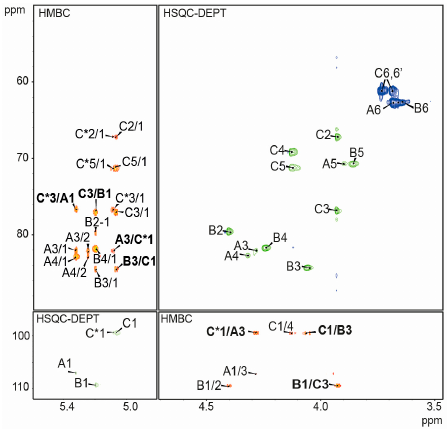
Figure 3. Selected 1 J H,C - and 3 J H,C -connectivities in HSQC-DEPT and HMBC spectra of the isolated PSI of Plesiomonas shigelloides 78/89 LPS. The inter-residue connectivities from the anomeric atoms in HMBC spectra are marked in bold. The spectra were obtained for 2 H 2 O solutions at 600 MHz and 30 °C. The uppercase letters refer to sugar residues in the O- specific polysaccharide, as described in Table 1.